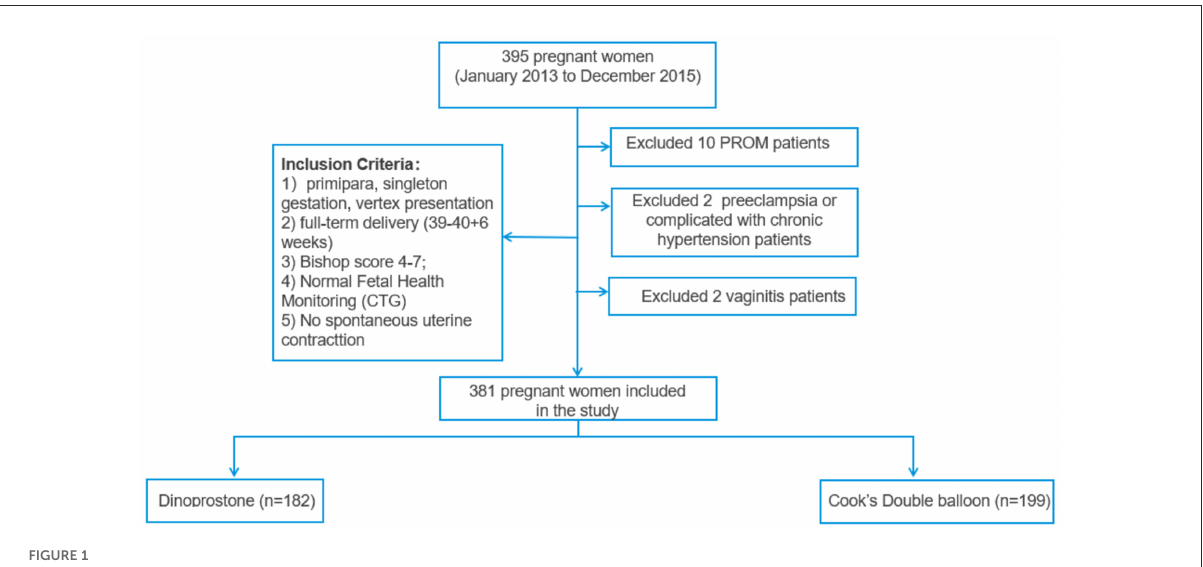
FIGURE1 Flow chart of patients’